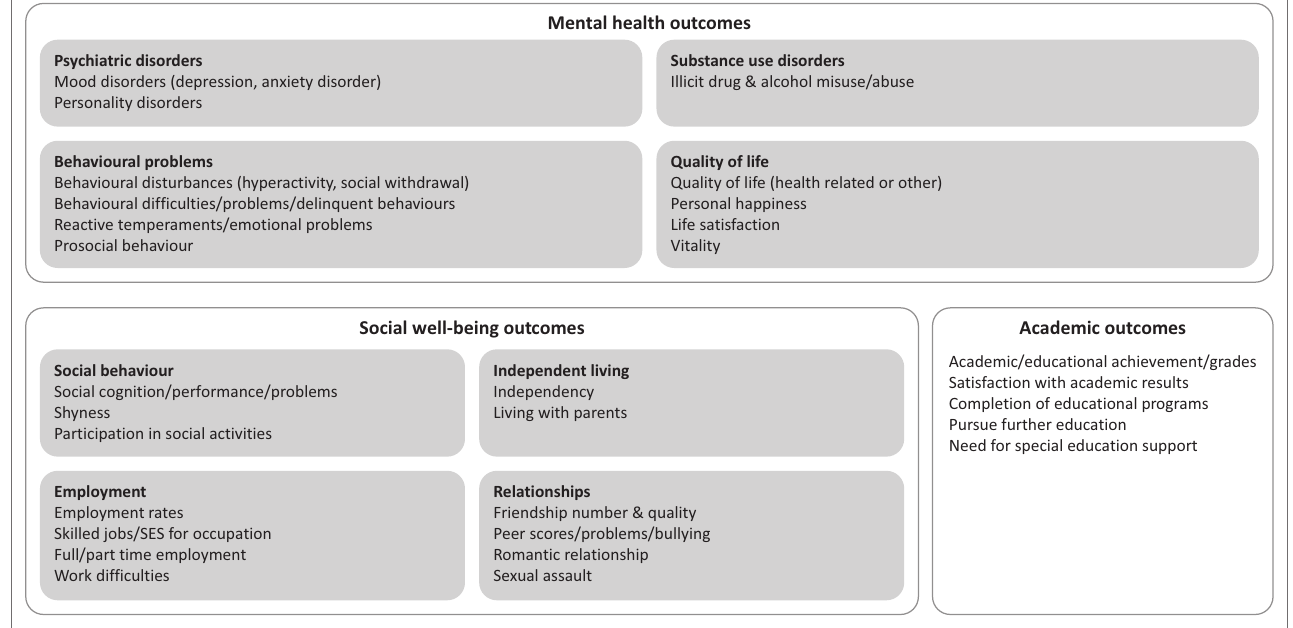
FIGURE 1: Classification of mental health, social well-being and academic